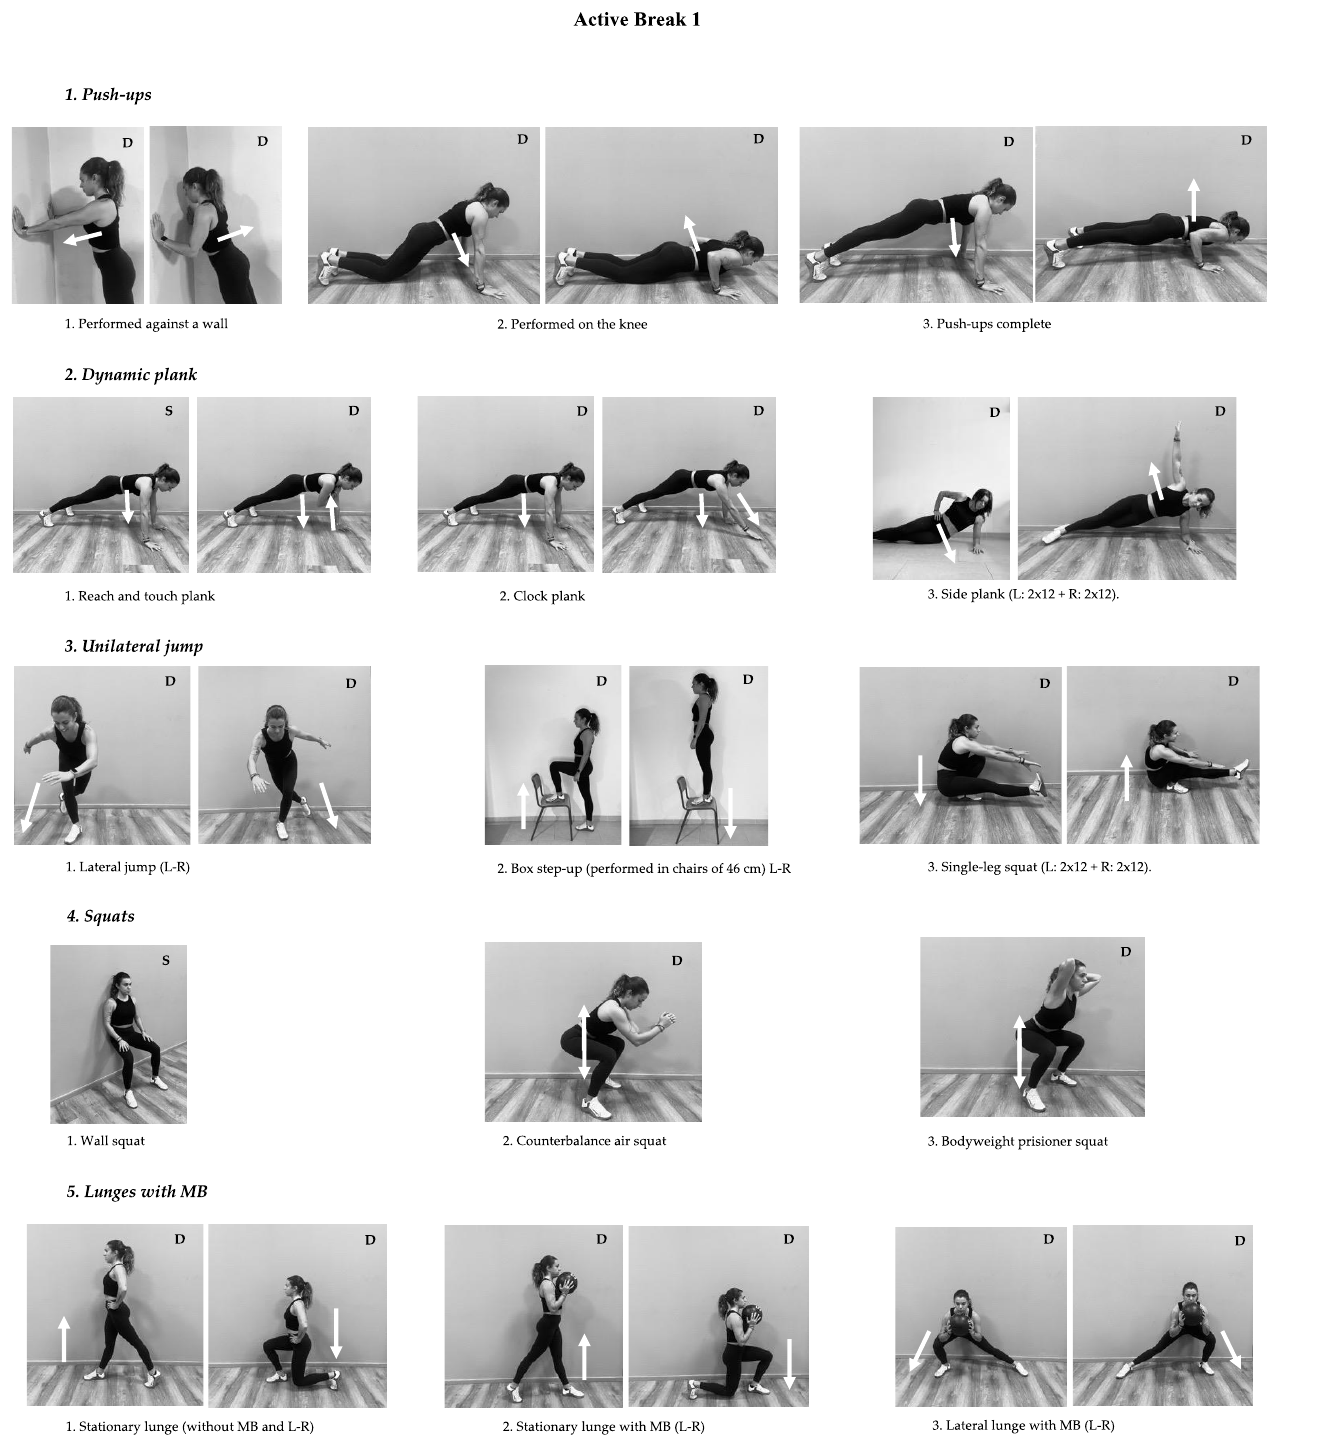
Figure 2. Description of Active Break 1 for high school students. (Arrows represent the movement direction, and S was used for static and D for dynamic movement).